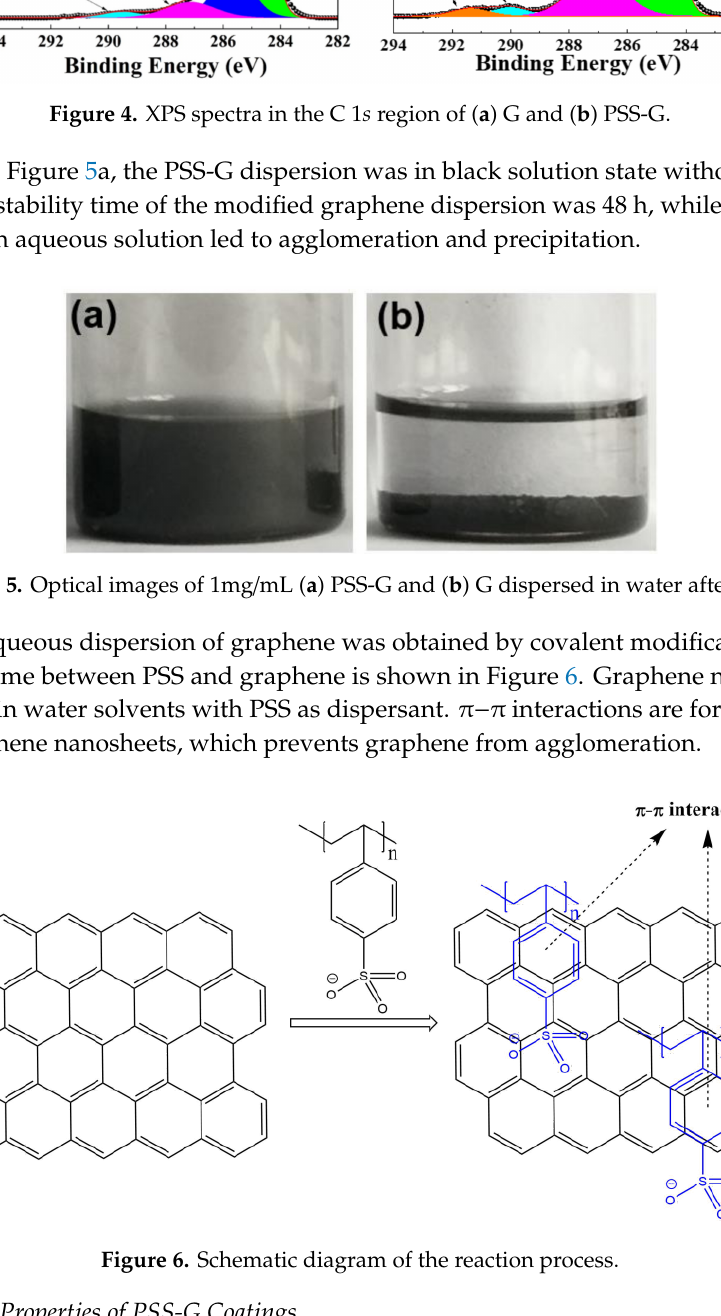
Figure 4. XPS spectra in the C 1 s region of ( a ) G and ( b ) PSS-G.